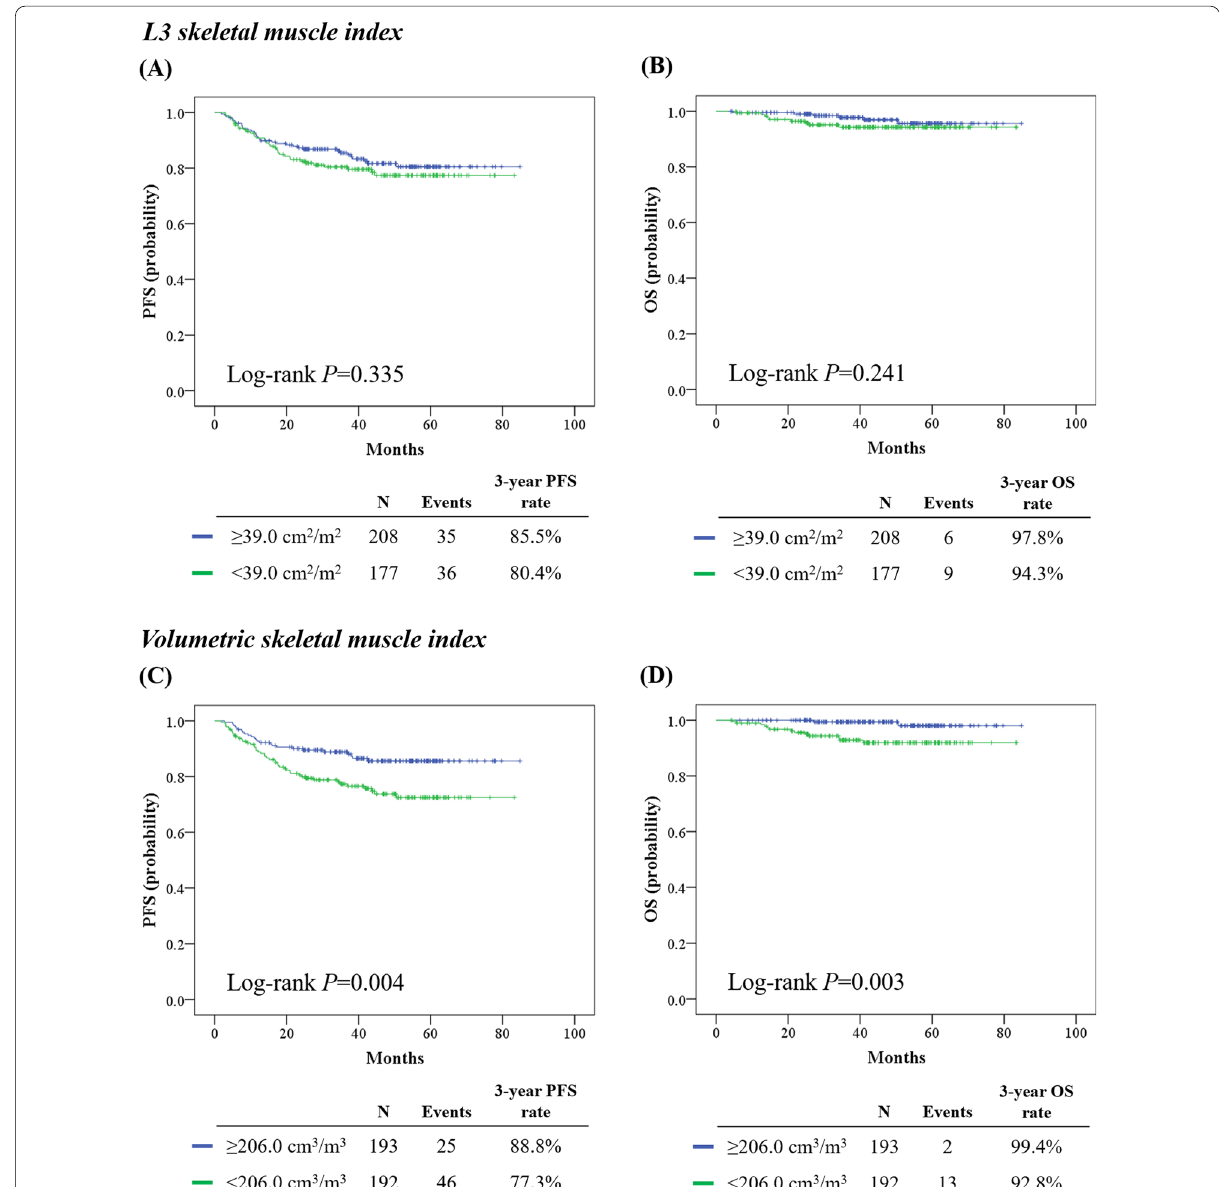
Fig. 3 Comparisons of survival outcomes between the sarcopenia and non‑sarcopenia groups (upper) and high‑ and low‑volumetric SMI groups (lower). A , C Progression‑free survival; B , D overall